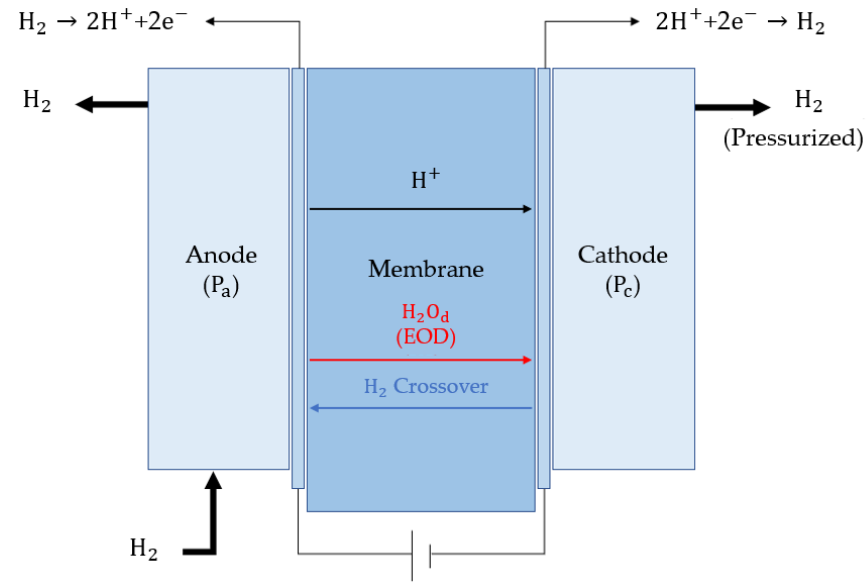
Figure 1. Schematic of an electrochemical hydrogen compressor.